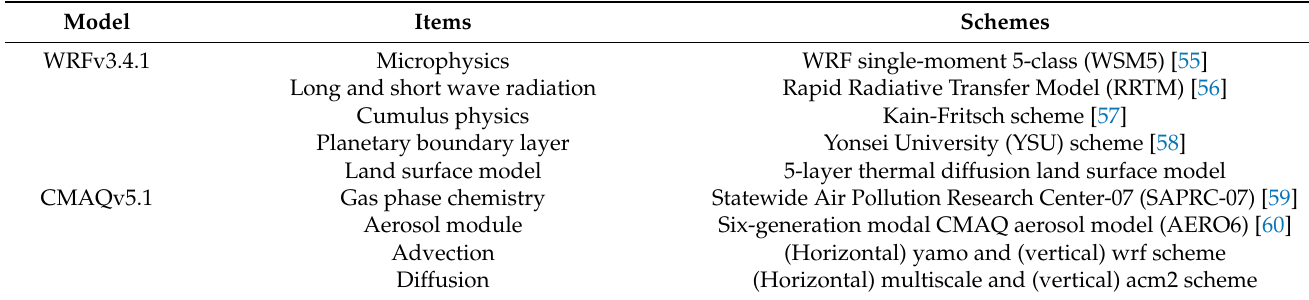
Table 1. Physical and chemical schemes for WRF/CMAQ